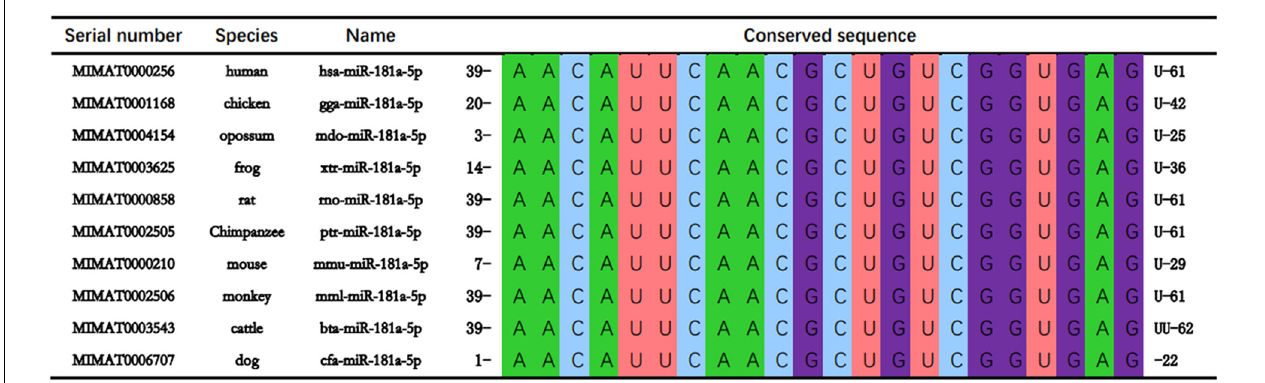
FIGURE 2 | miR-181a-5p are conserved in at least 10 vertebrate species including human (Homo sapiens; hsa), mouse (Mus musculus; mmu), chicken (Gallus gallus; gga), opossum (onodelphis domestica; mdo), frog (Xenopus tropicalis; xtr), rat (Rattus norvegicus; rno), Chimpanzee (Pan troglodytes; ptr), monkey (Macaca mulatta; mml), cattle (Bos taurus; bta), and dog (Canis familiaris; cfa).